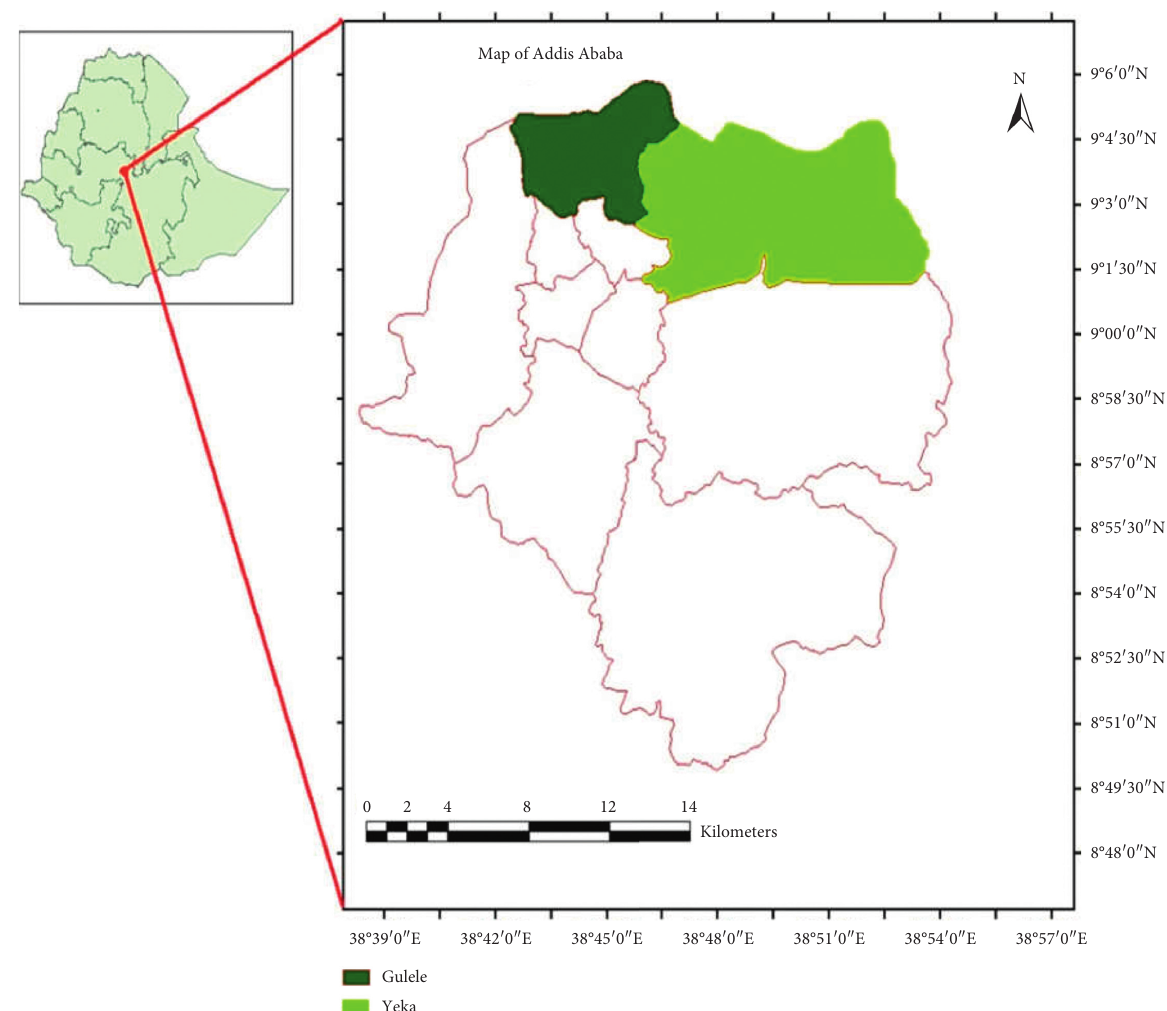
Figure 1: Map of the study area (samples were taken from Gullele and Yeka, EMA, Figure 2. Herbs were dominant and represented by (91) 50.84% species, shrub by (46) 25.67%, tree by (26)14.53%, and tree/shrub by (9) 5.03% species while climber by (7) 3.9% species. From the total woody species, Eucalyptus globulus (952/ha), Juniperus procera (369/ha), and Carissa spinarum (304/ha) were the most abundant species in the study area, whereas species such as Millettia ferruginea , Ficus sur , Croton macrostachyus , and Prunus africana were the least abundant species having only one individual per ha (see Table 1).